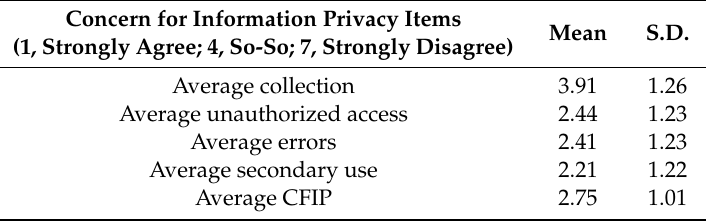
Table 2. Descriptive statistics on concern for information privacy (CFIP).